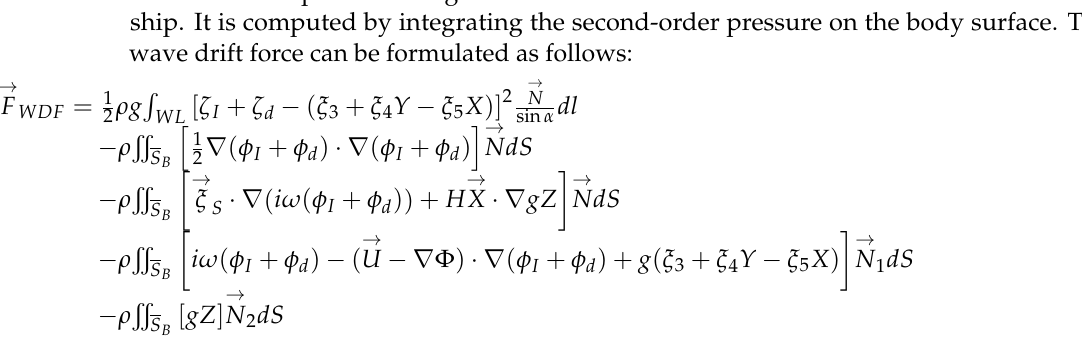
Figure 7. Wave contours near the KVLCC2: V = 6 knots, λ /L = 0.6.